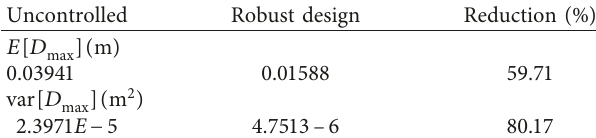
Table 3: Statistical moments of maximum interstory drift.